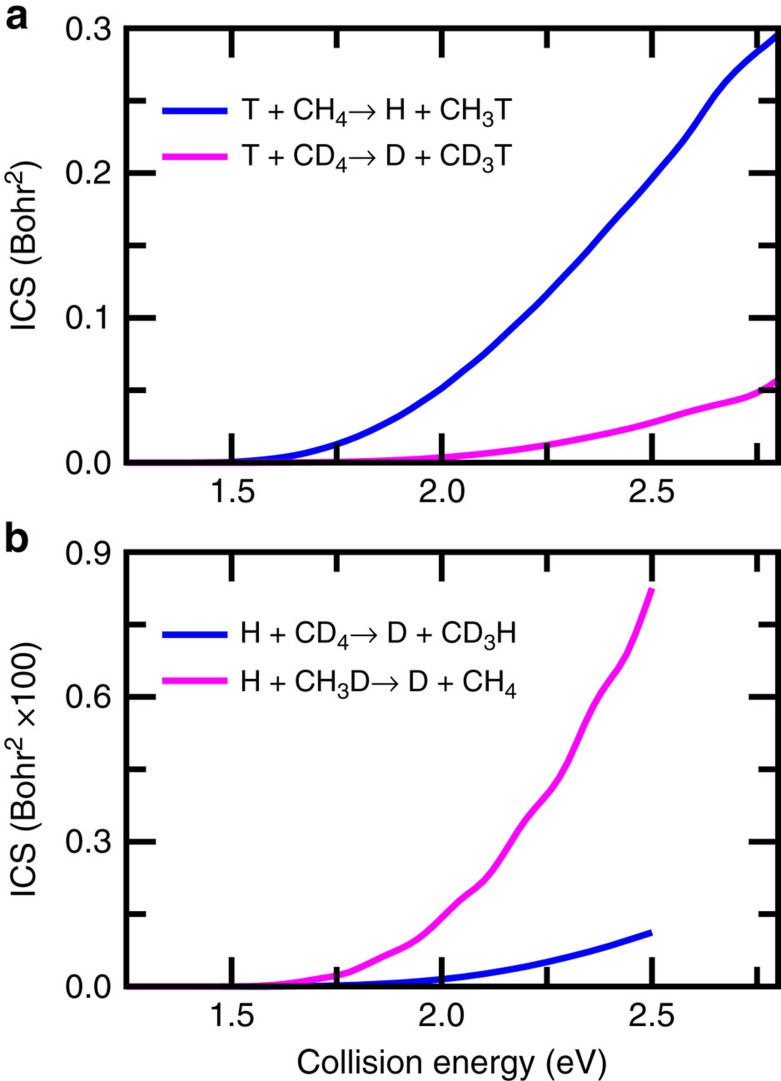
Integral cross-sections.(a) The integral cross-sections for the T+CH4/CD4 substitution reactions as a function of collision energy; (b) same as a except for the H+CD4/CH3D→D+CD3H/CH4 reactions.